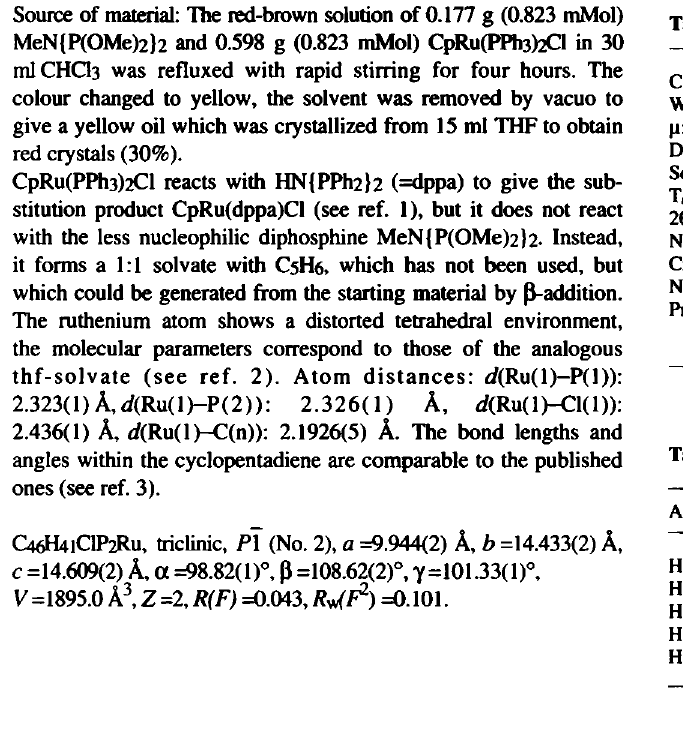
Table 1. Parameters used for the X-ray data collection